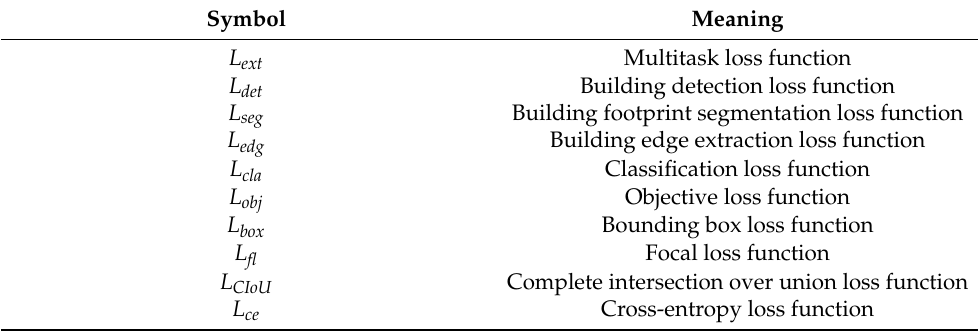
Table 1. The symbols used for the loss functions in this paper and their meanings. Symbol Meaning L ext Multitask loss function L